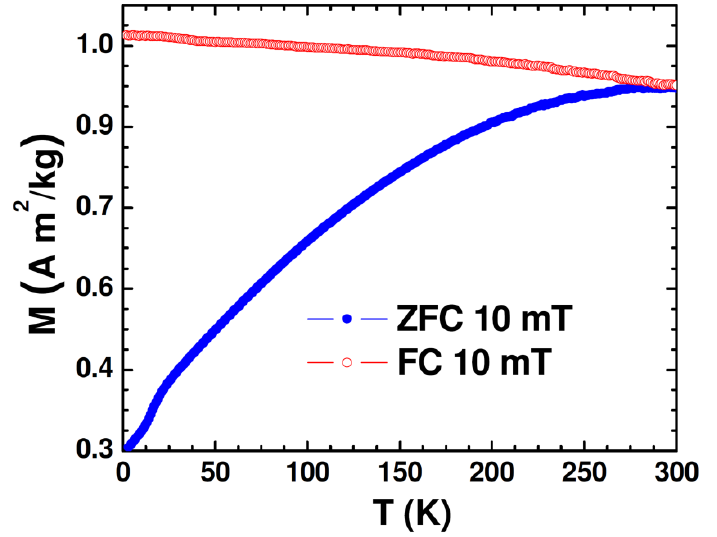
Figure 2. Zero-field-cooled (ZFC) and field-cooled (FC) magnetization curves (M-T) for Au-Fe O 3 4